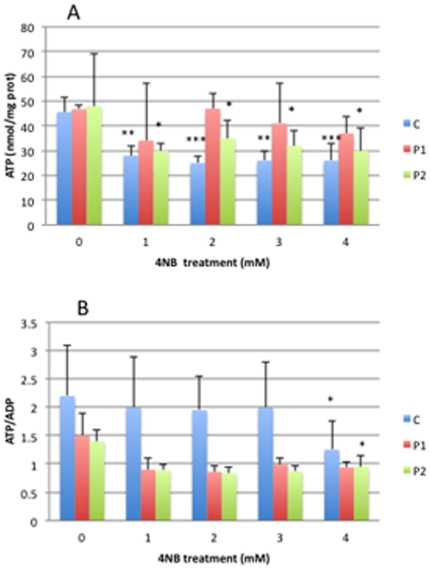
Adenine nucleotides levels in control (n = 5), P1 and P2 skin fibroblasts after 4-NB treatment (ATP in panel A and ATP/ADP in panel B).The values are nmol/mg-protein, P1 and P2 after 4 mM DMSO treatment. (* P<0.05 vs. controls; **P<0.01 vs. controls; ***P<0.001 vs. controls).